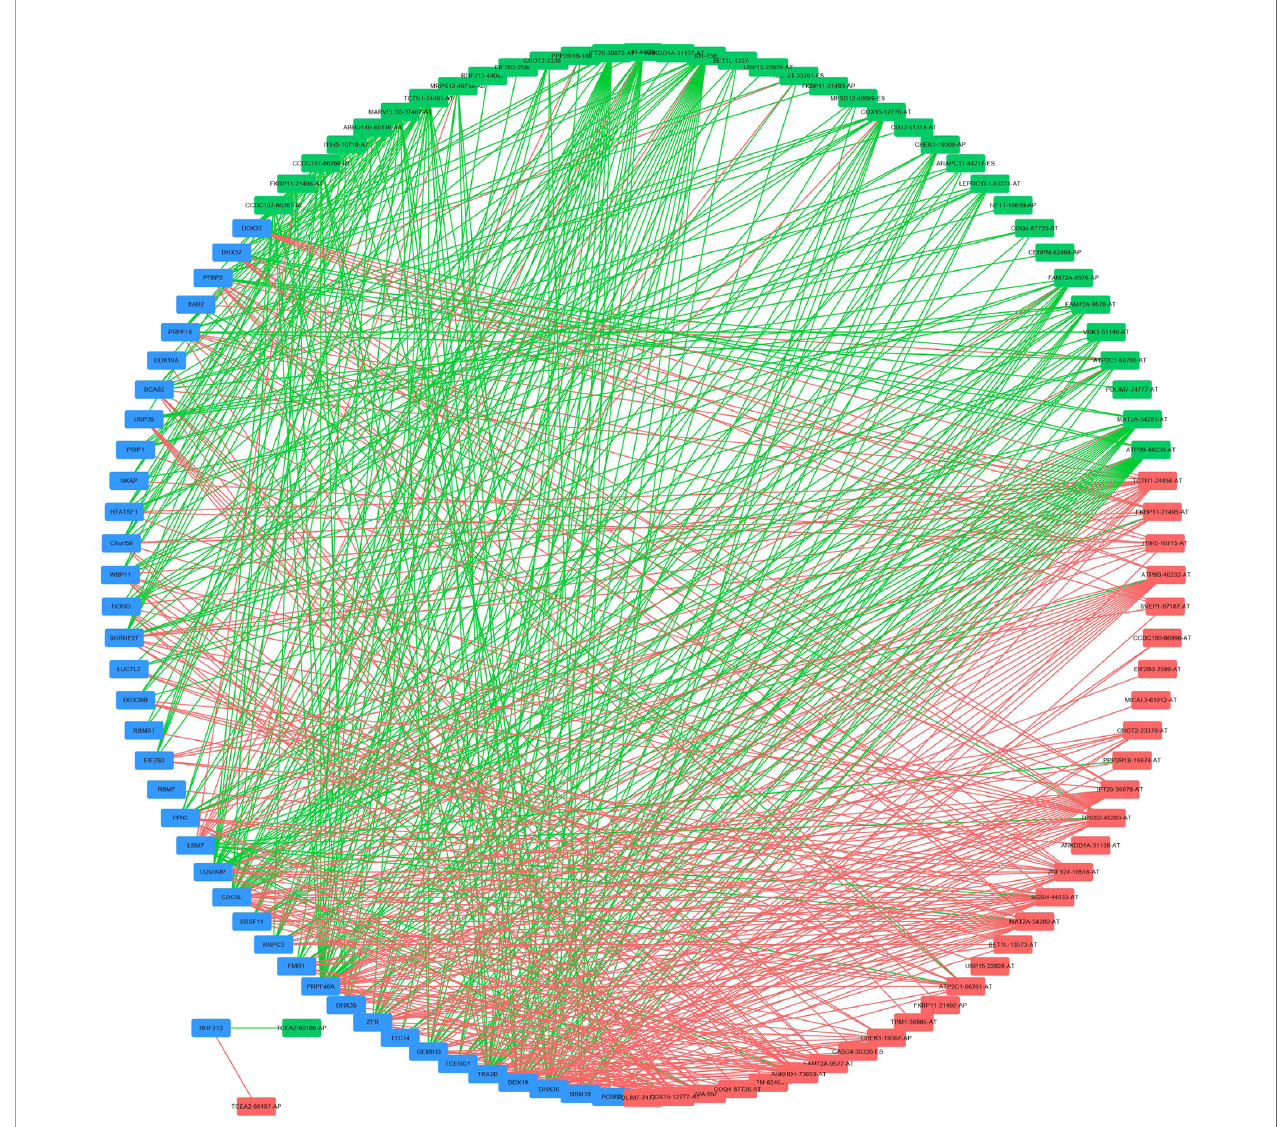
FIGURE 8 | Regulatory network between SFs and AS events. Thirty-nine SFs (blue) were signi fi cantly related to 68 survival-associated AS events consisting of 37 adverse AS events (green) and 31 favorable AS events (red). The majority of adverse AS events were positively correlated with SF expression (green lines) and the most favorable AS events were negatively correlated with SF expression (red